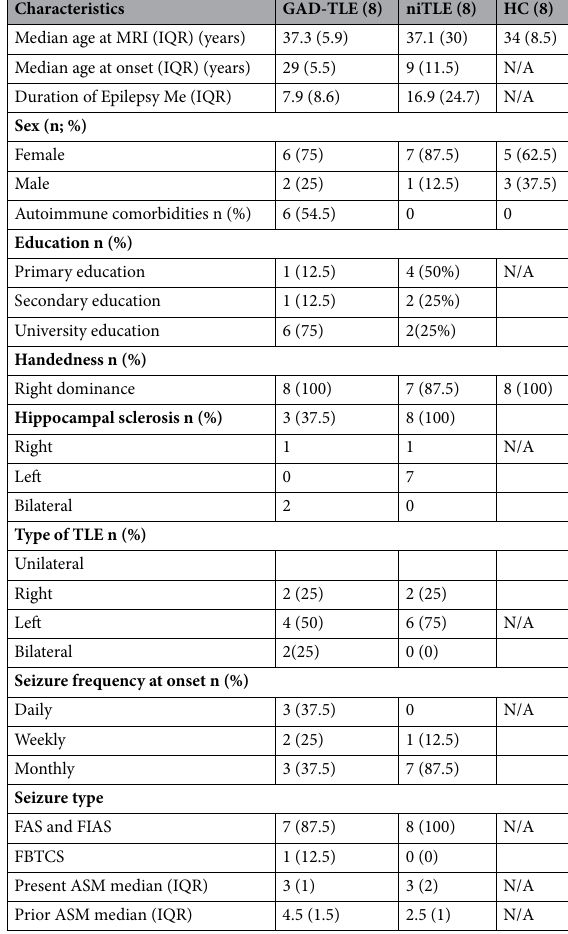
Table 1. Demographic, clinical and MRI features of the three groups evaluated. TLE temporal lobe epilepsy, FAS focal aware seizures, FIAS focal impaired awareness, FBTCS focal to bilateral tonic–clonic seizure, ASM antiseizure medication, Me median, IQR interquartile range, N/A not